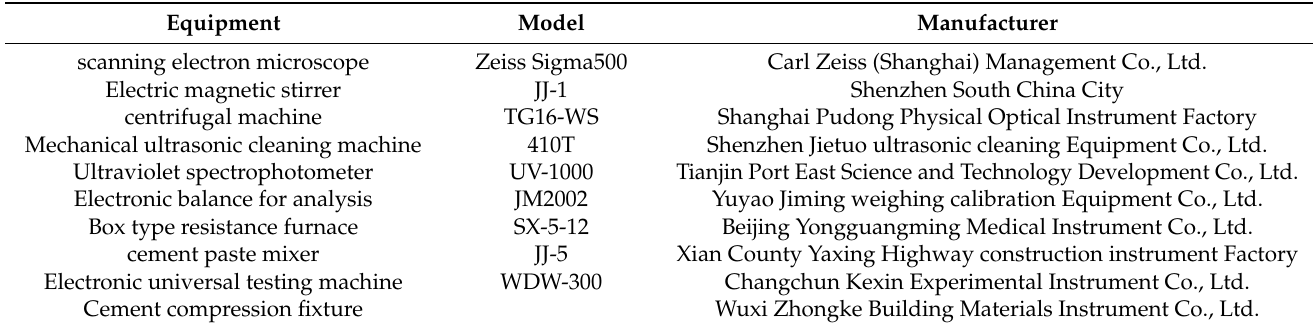
Table 2. The equipment and instruments used in the experiment.